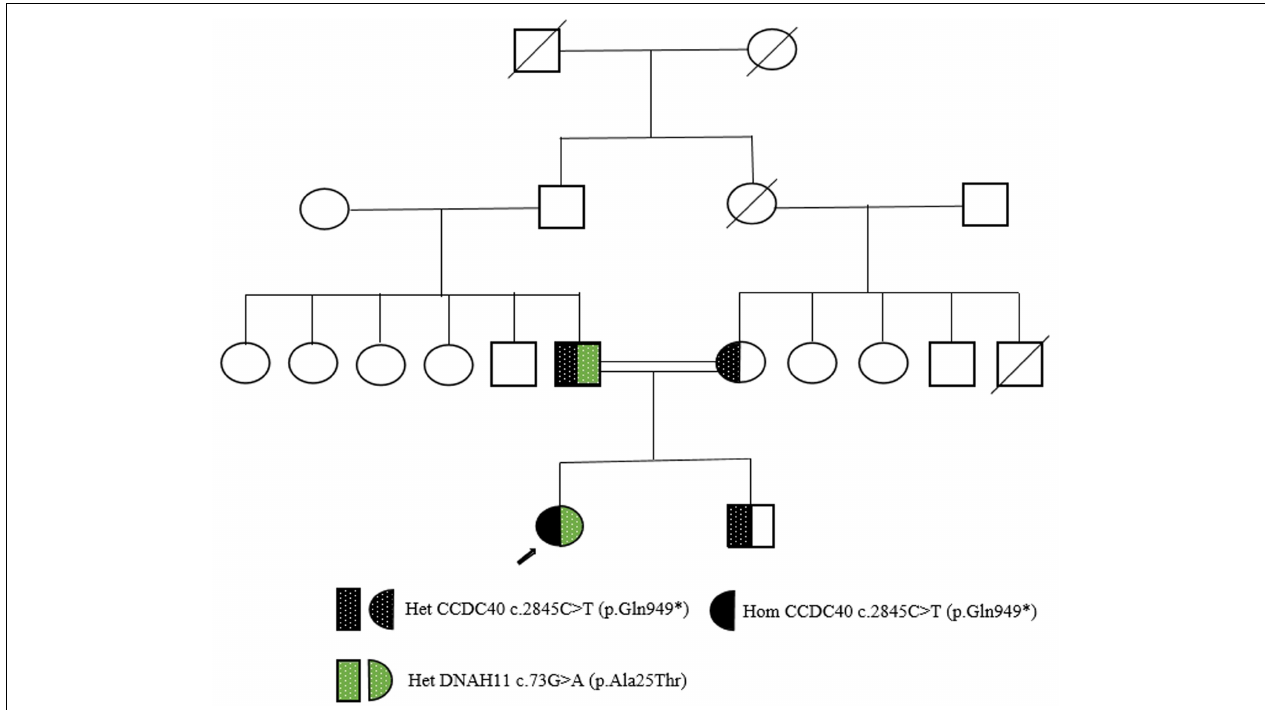
FIGURE 2 | Pedigree of a Han-Chinese patient with Kartagener’s syndrome. Square represents male; circles represent females; arrow presents the proband; double lines indicate consanguinity. Het, heterozygous; Hom,